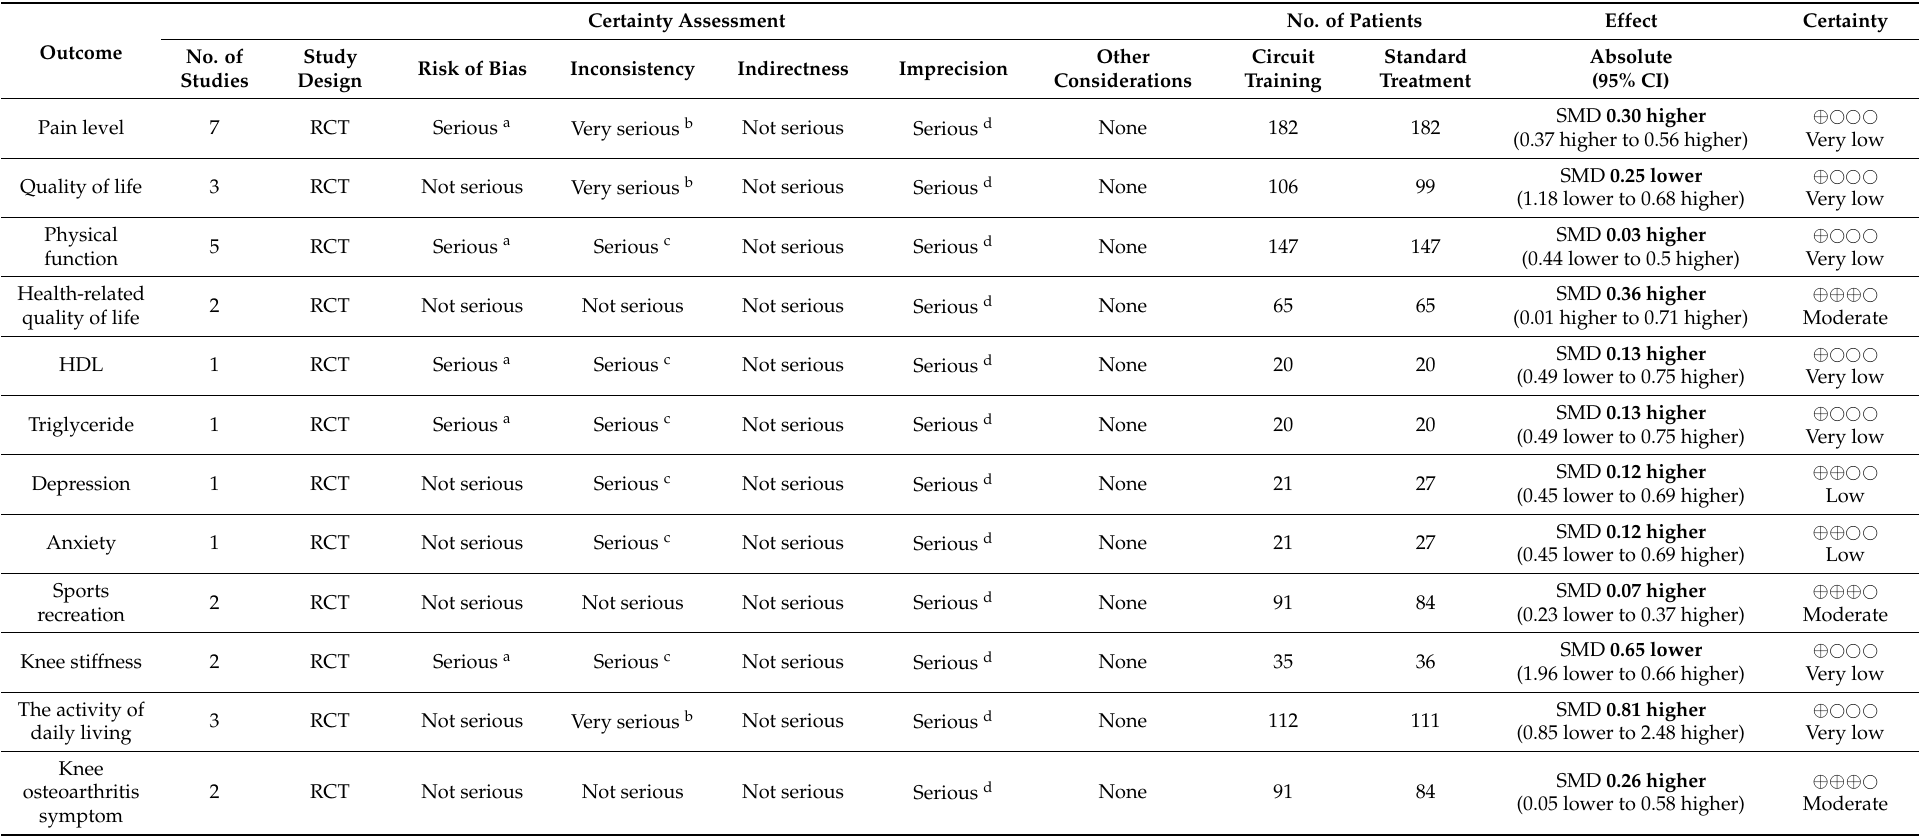
Table 2. Summary of finding using GRADE quality